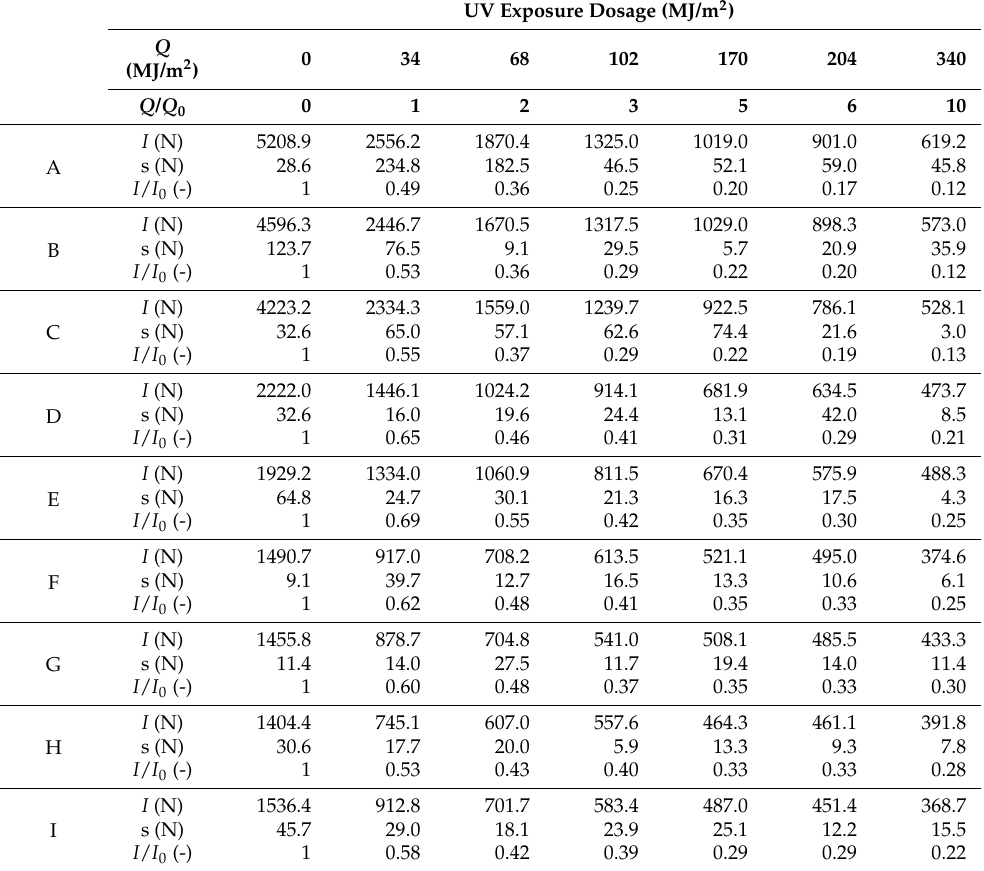
Table 3. Tensile strength and the retention fraction of tensile